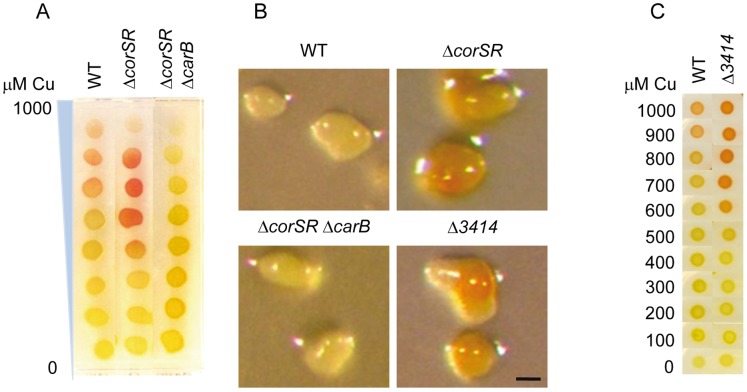
Carotenoid accumulation in different strains during growth and development.
A. WT, ΔcorSR, and ΔcorSR ΔcarB strains were grown in the absence of copper, concentrated at an OD600 of 15, and spotted onto CTT agar plates containing a copper gradient from 0 to 1000 µM. Pictures were taken after 48-h incubation. B. Carotenoid accumulation during development. In these experiments cells grown in the absence of copper were concentrated at an OD600 of 15 and spotted onto CF media with 40 µM copper. Pictures were taken at 72 h. Bar represents 100 µm. C. Carotenoid accumulation in the Δ3414 and the WT strains during growth in the presence of different copper concentrations. Cells were grown in the absence of copper, concentrated to an OD600 of 15, and spotted onto CTT agar plates containing the indicated copper concentrations.